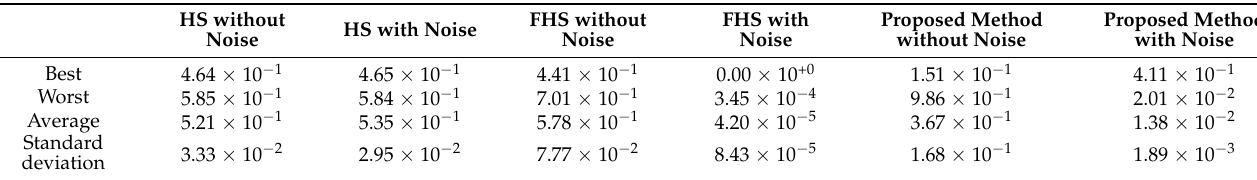
Table 7. Comparison with other existing methods [26]. Table 8. Comparison with other existing methods [46]. HS, harmony search; FHS, type-1 fuzzy harmony search